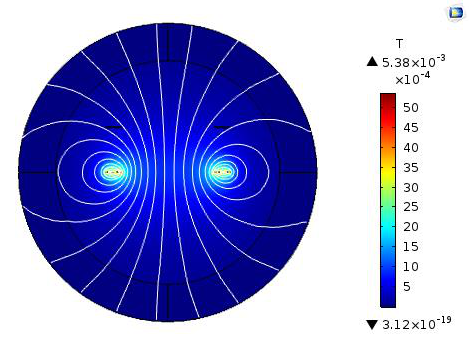
Figure 8. Magnetic flux line and distribution in 2D cross-section.